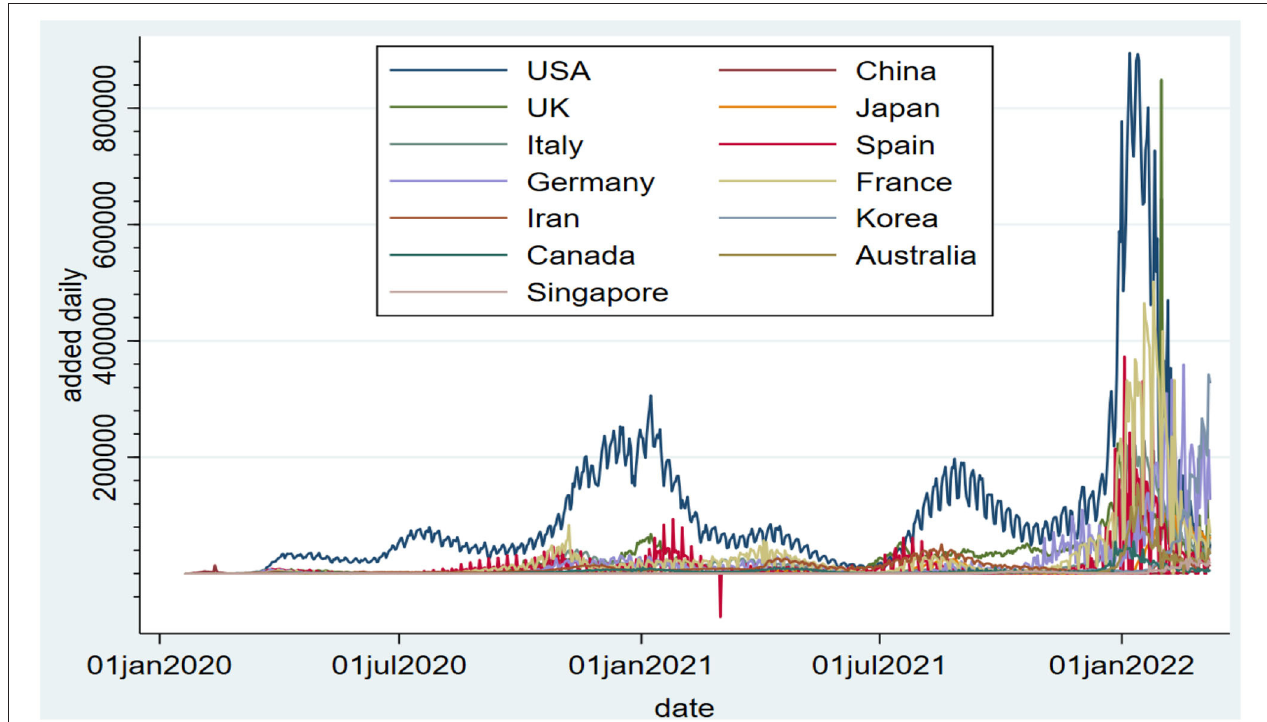
FIGURE 1 | COVID-19 daily value added.